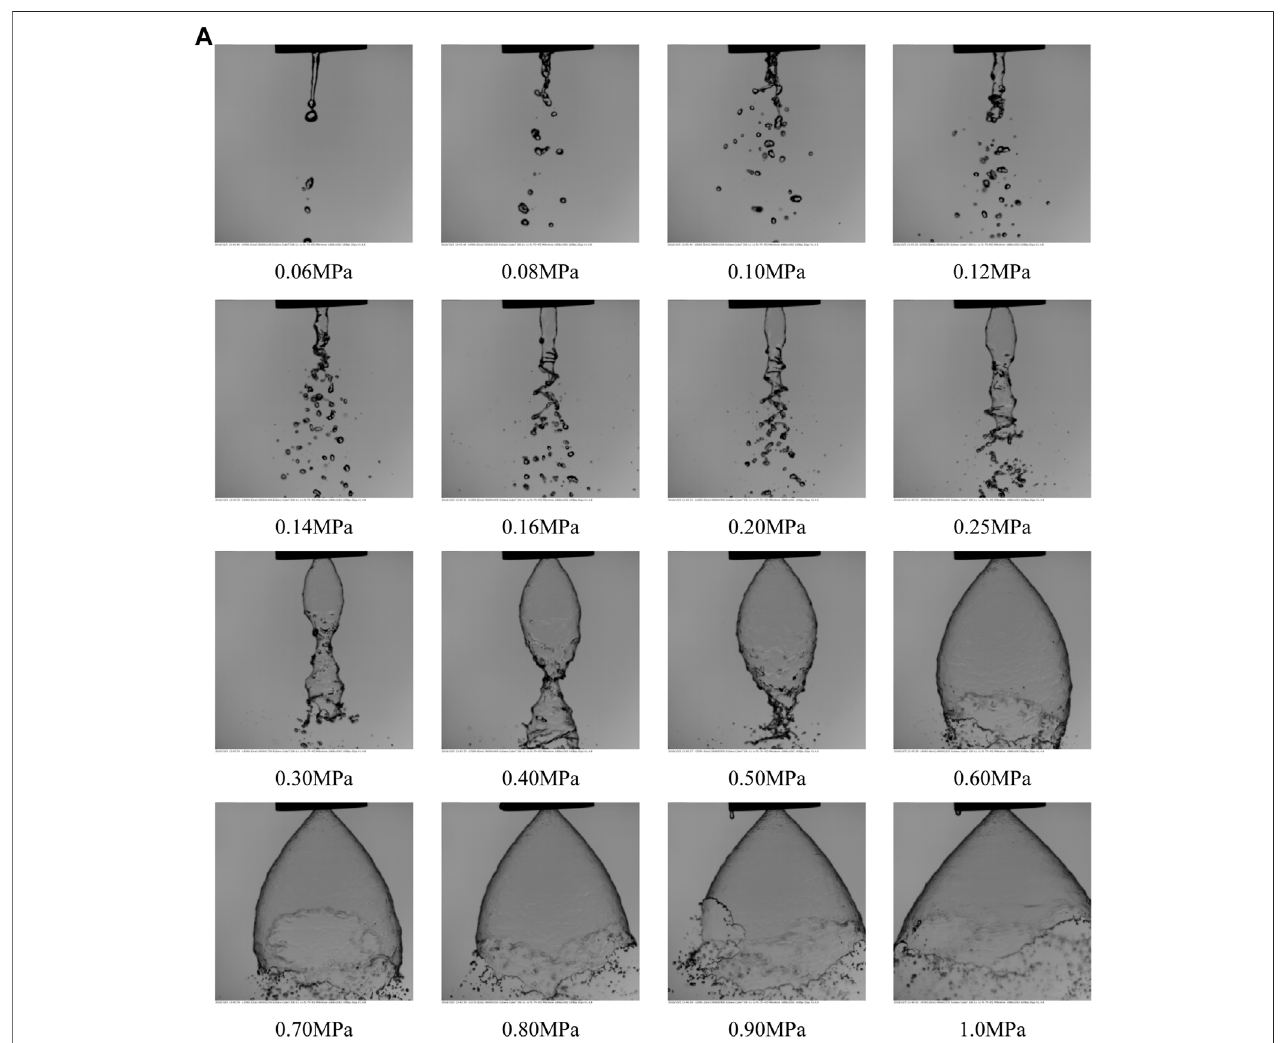
FIGURE 8 | Atomization morphology generated by the (A) W-7 experiment, (B) W-8 experiment, and (C) W-9 experiment.